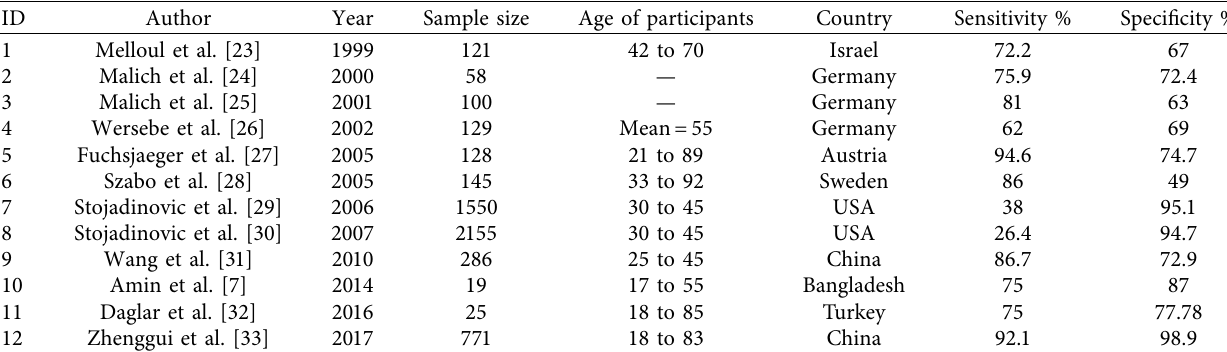
Table 1: Summary of studies included in the